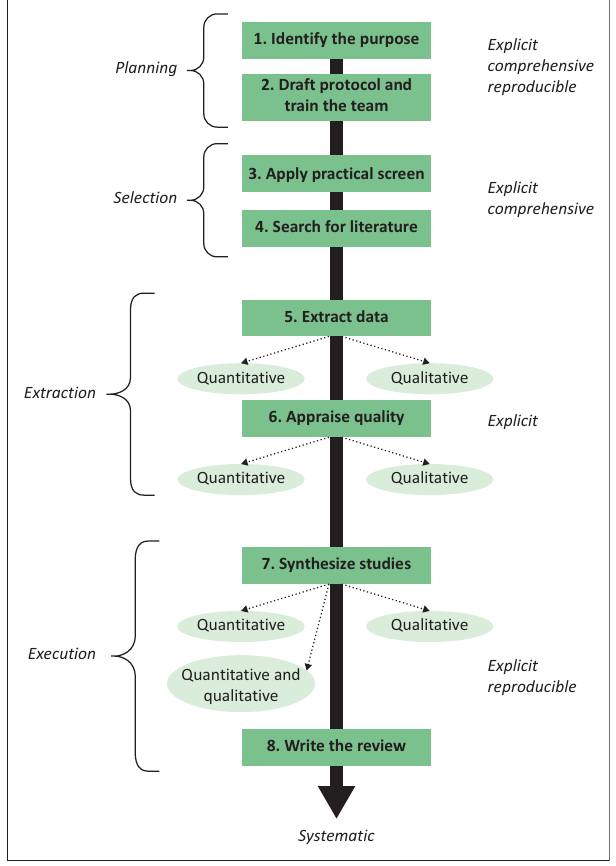
FIGURE 2: A systematic guide to literature review development (Okoli